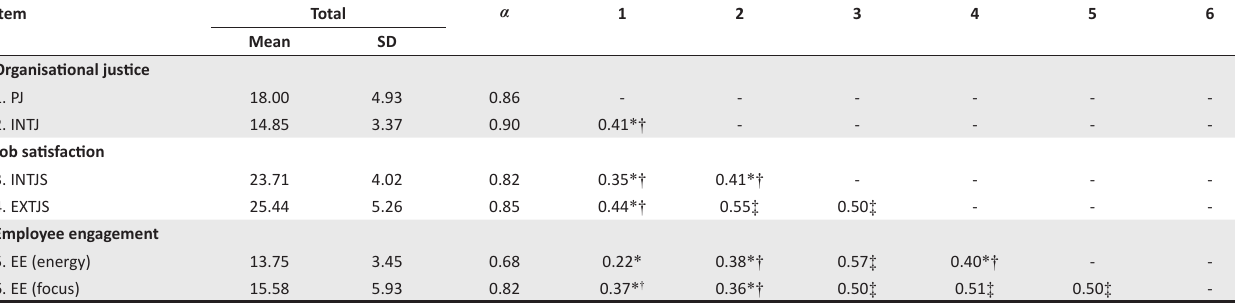
TABLE 2: Descriptive statistics and Pearson correlation